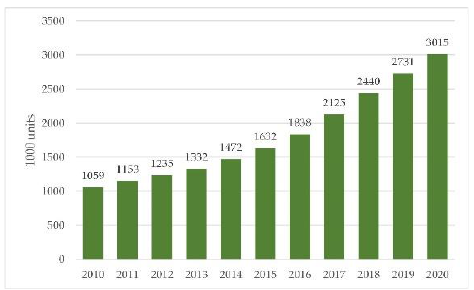
Figure 2. Number of robots in the world [1].